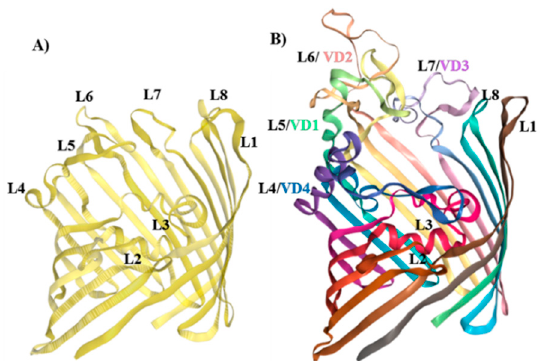
Figure A1. Antibodies to PorB/VD and nMOMP are cross-reactive and have limited cross-reactivity with NL PorB. ( A ) Anti-PorB/VD sera tested against nMOMP by ELISA. Sera from individual mice in each immunization group were tested in duplicate wells and IgG are expressed in µg/mL ± SEM. Anti-PorB/VD1: upward triangle; anti-PorB/VD2: square; anti-PorB/VD3: downward triangle; anti-PorB/VD4: diamond; anti-NL PorB: circle; anti-rMOMP: dotted circle. ≈ p < 0.0001 by one-way ANOVA with Tukey’s multiple comparisons test; ( B ) Anti-NL PorB sera tested against PorB/VDs and NL PorB as above. ≈ p < 0.0002 as above and * p < 0.05 by MannWhitney test; ( C ) Anti-PorB/VD sera tested against NL PorB as above.